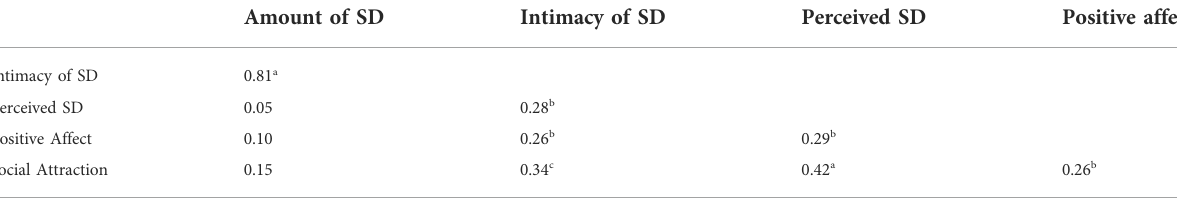
TABLE 7 Pearson correlation for different self-disclosure (SD) measurements, positive affect, and social